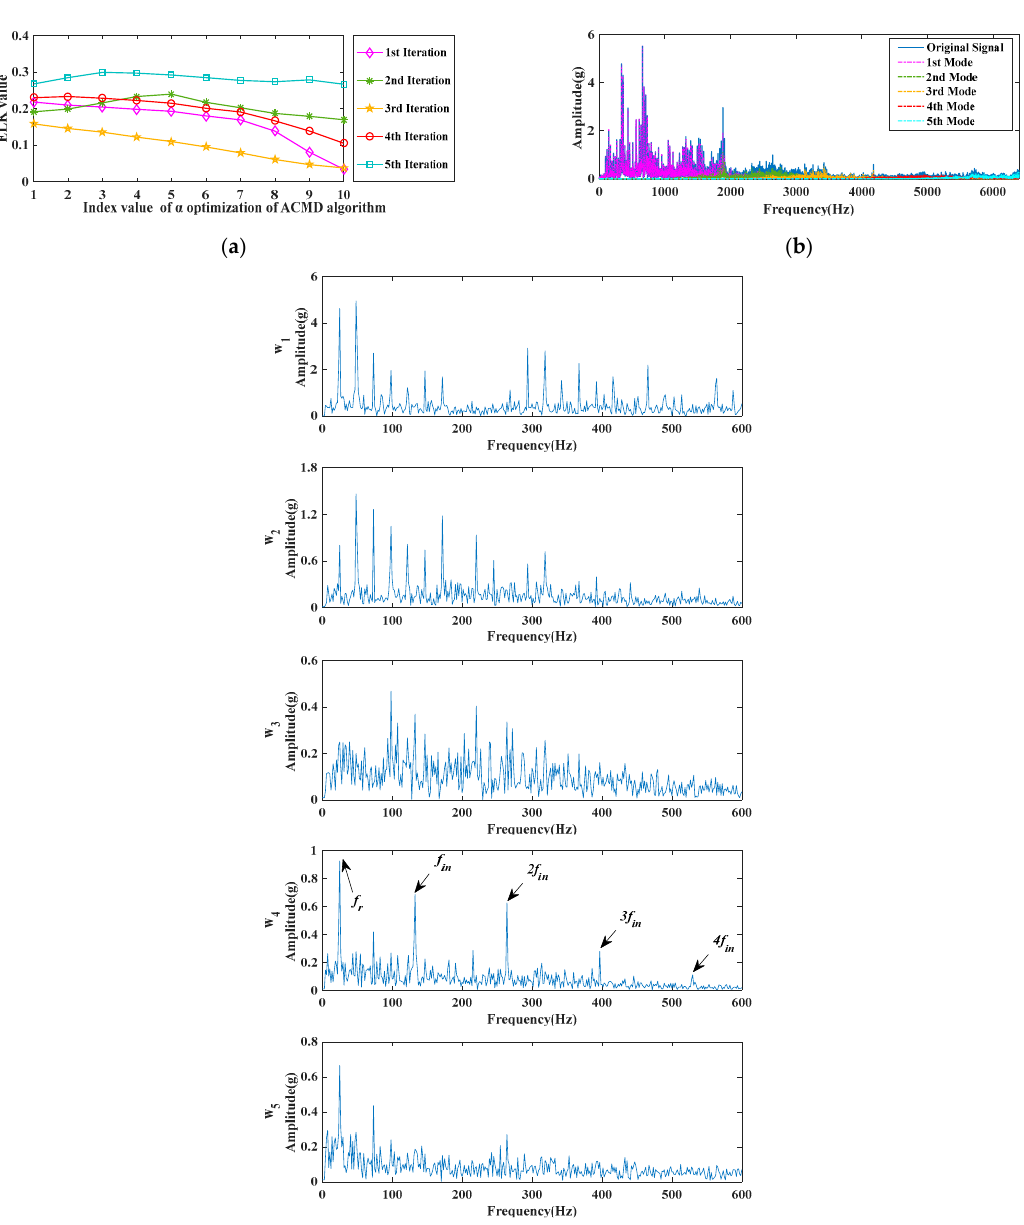
Figure 16. Proposed diagnostic strategy analysis results of experimental inner race fault signal: ( a ) ELK values with different α at each F in ; ( b ) frequency spectrum distribution results of the obtained modes; ( c ) envelope spectrums of the obtained modes.